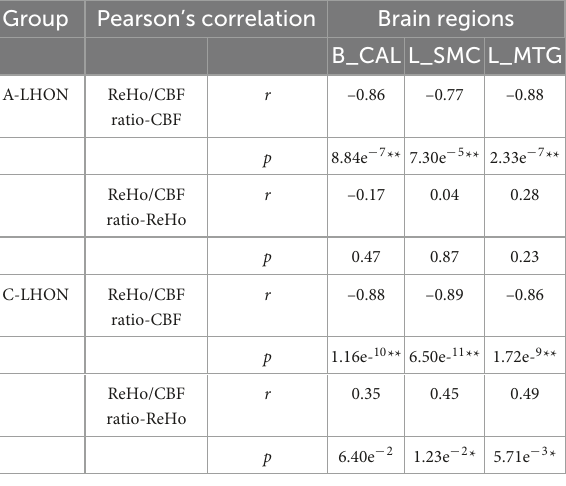
Group Pearson’s